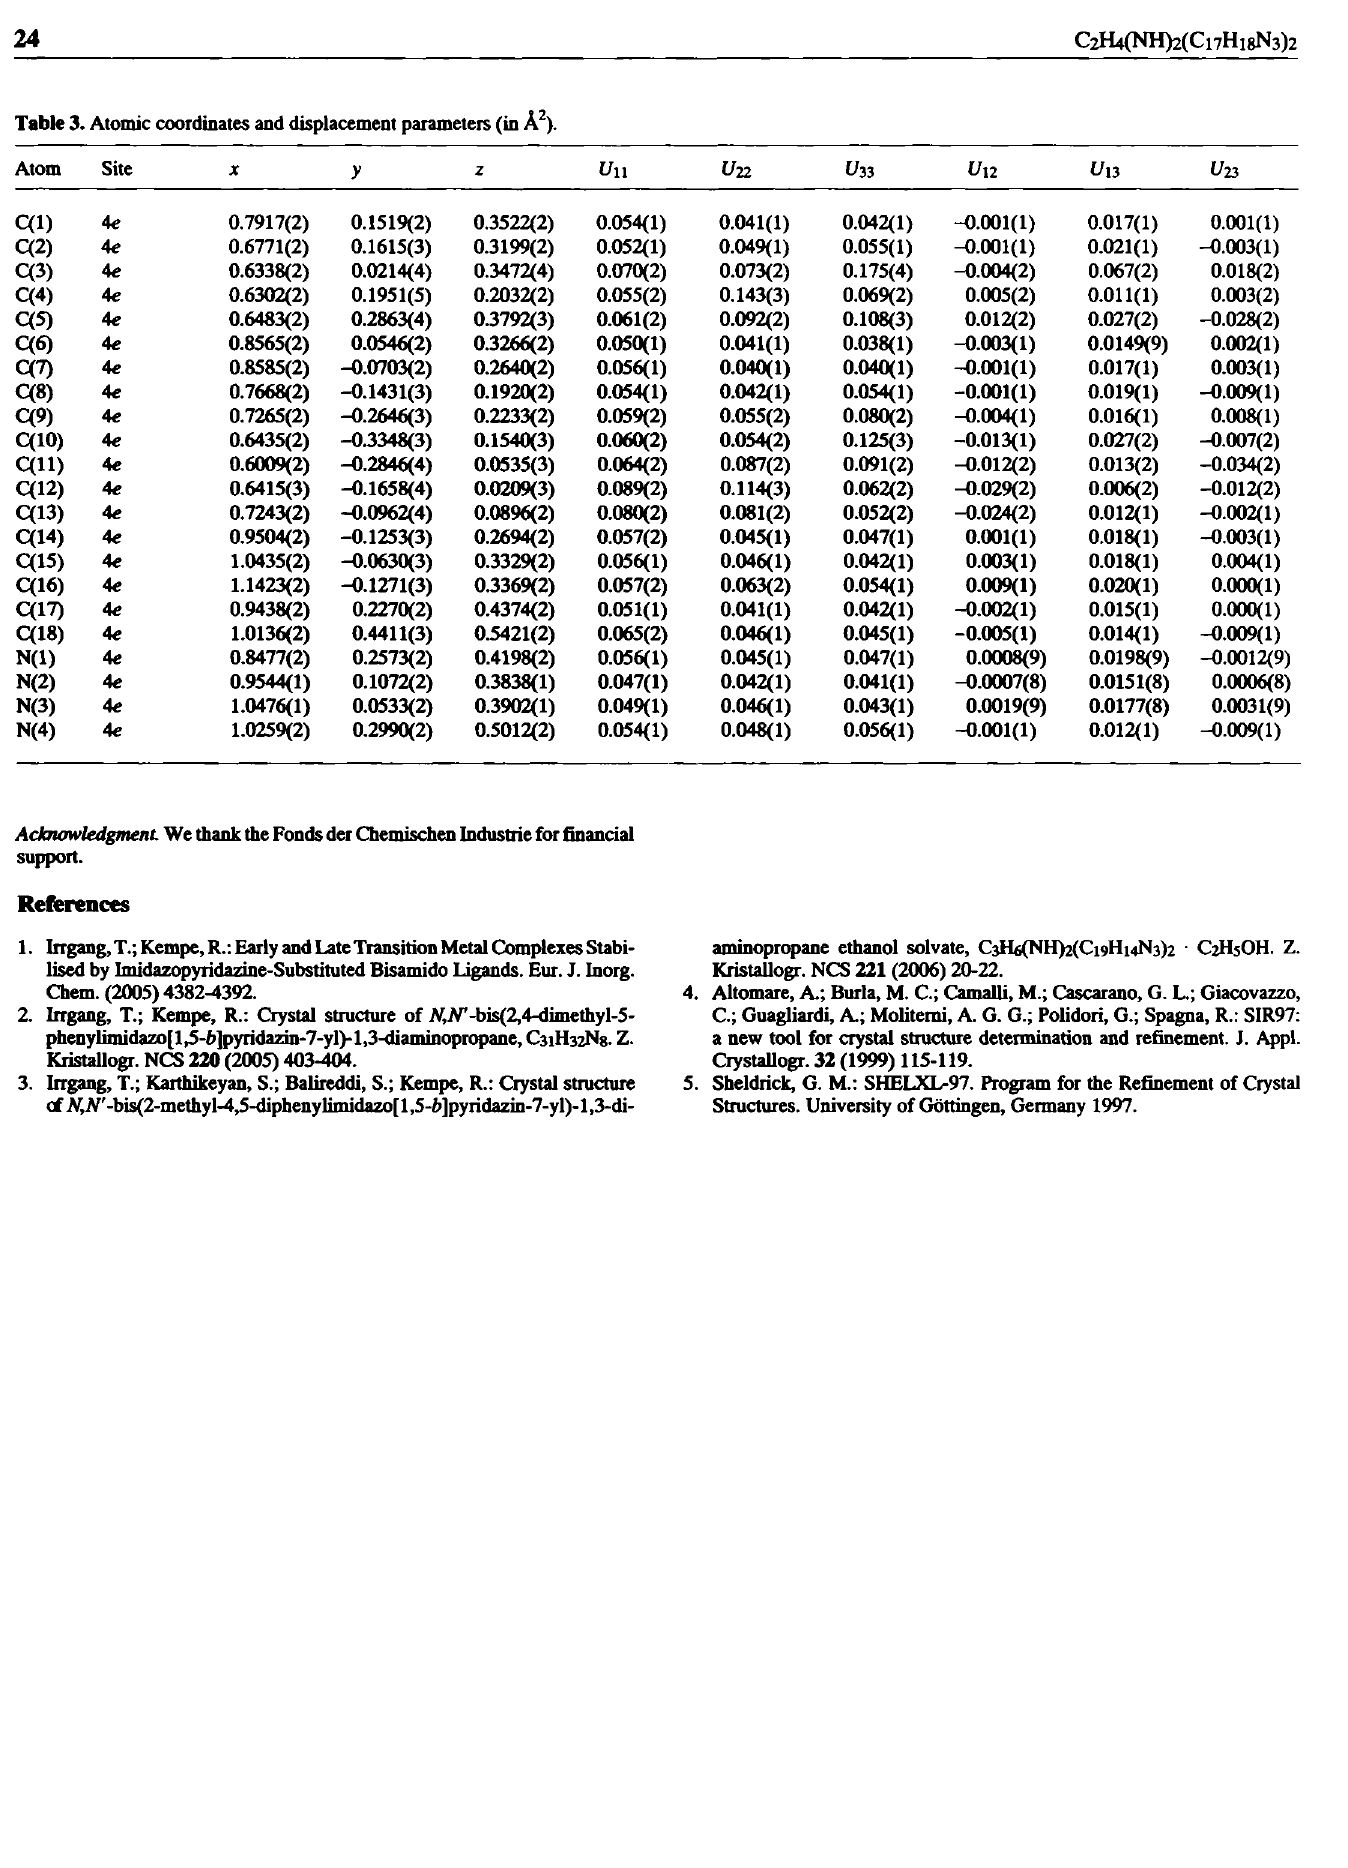
Table 3. Atomic coordinates and displacement parameteis (in Ä 2